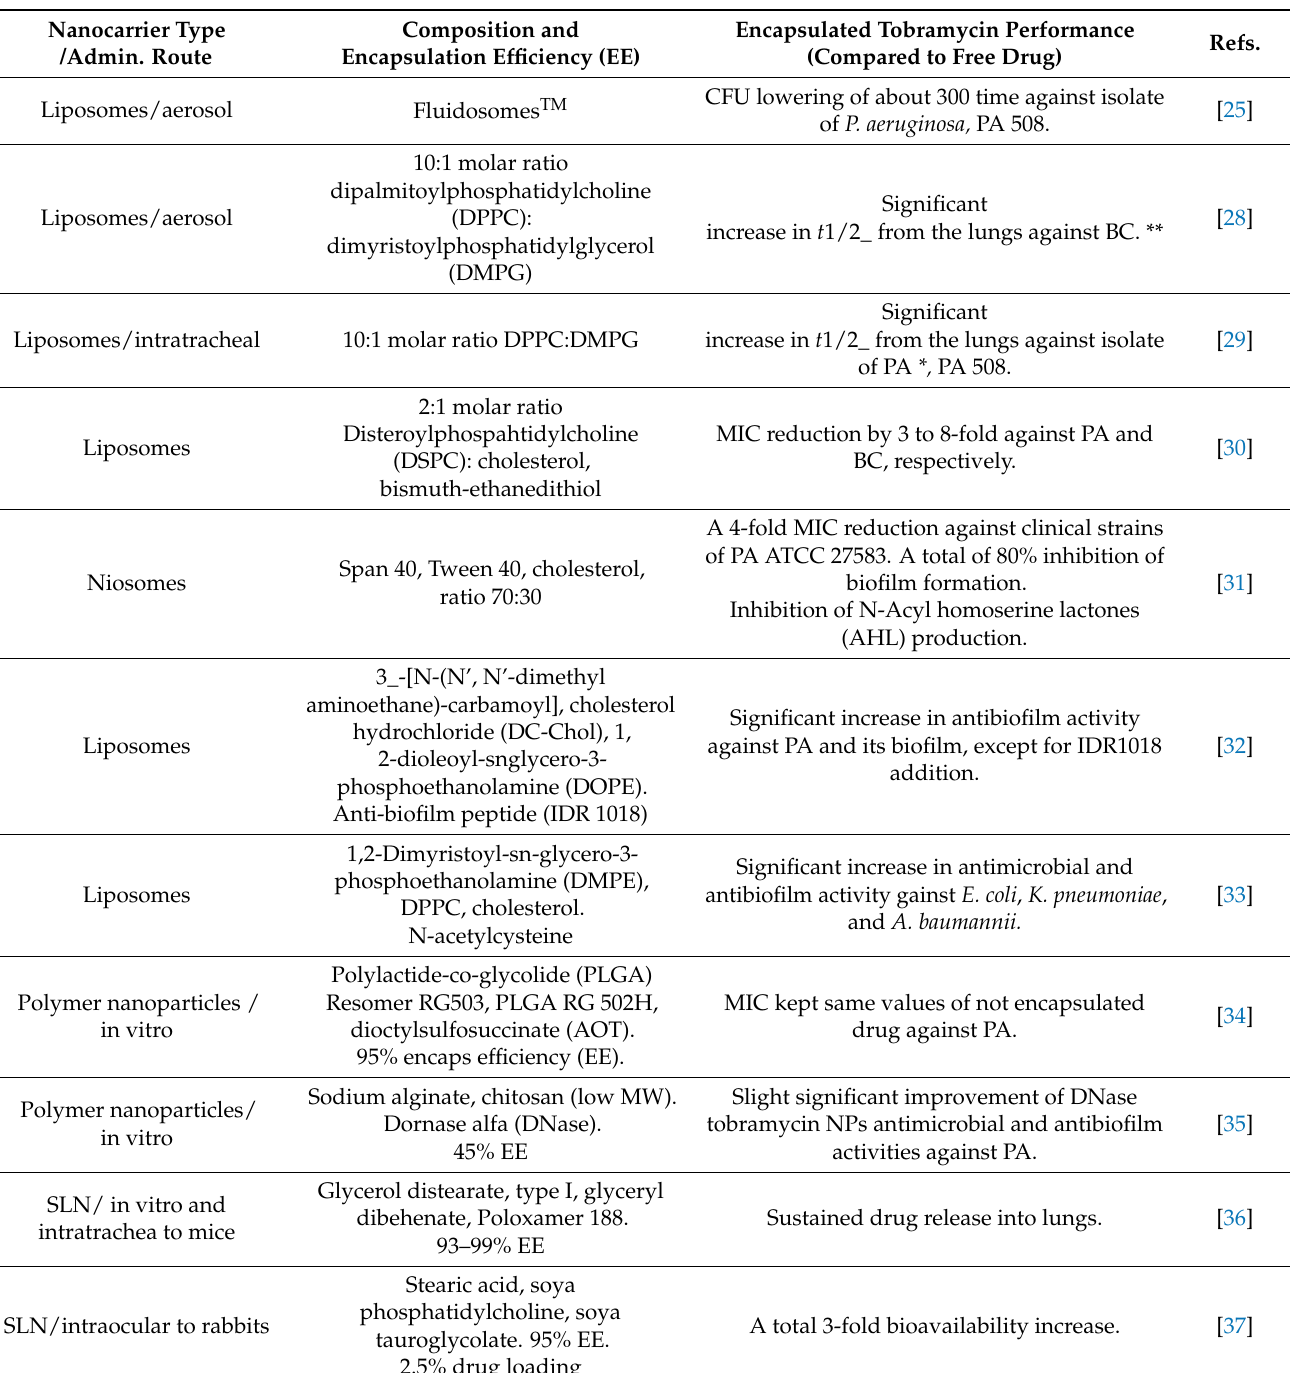
Table 1. Examples of Tobramycin loaded nanocarriers, their composition and